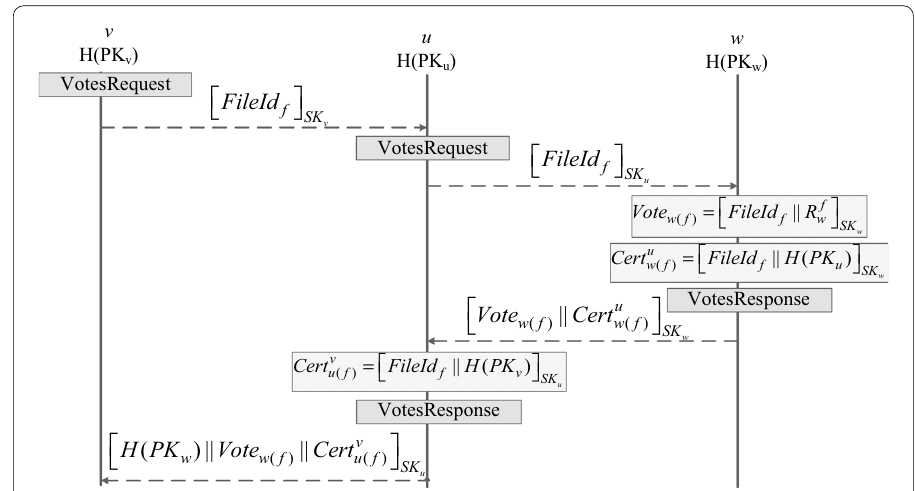
Fig. 4 Security protocol of evaluation collection process. Node W’s evaluation ticket of service F, including the ID of service F and W’s evaluation of f. The message is encrypted with the private key of W, the evaluation ticket will be returned along the query path, and other nodes cannot forge it. The other part of the body of the response message is the proof of transaction between the nodes